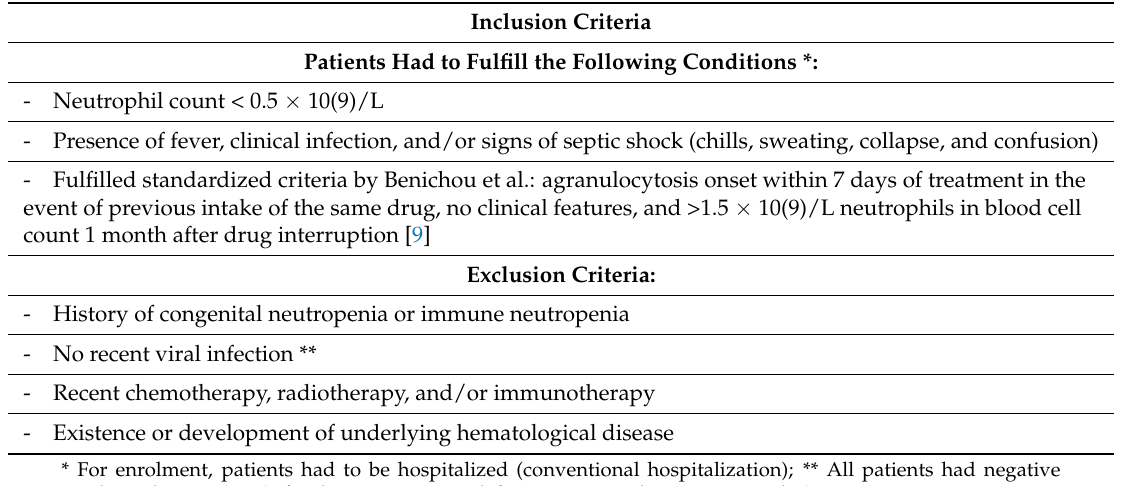
Table 1. Criteria for inclusion in and exclusion from the study (adapted from